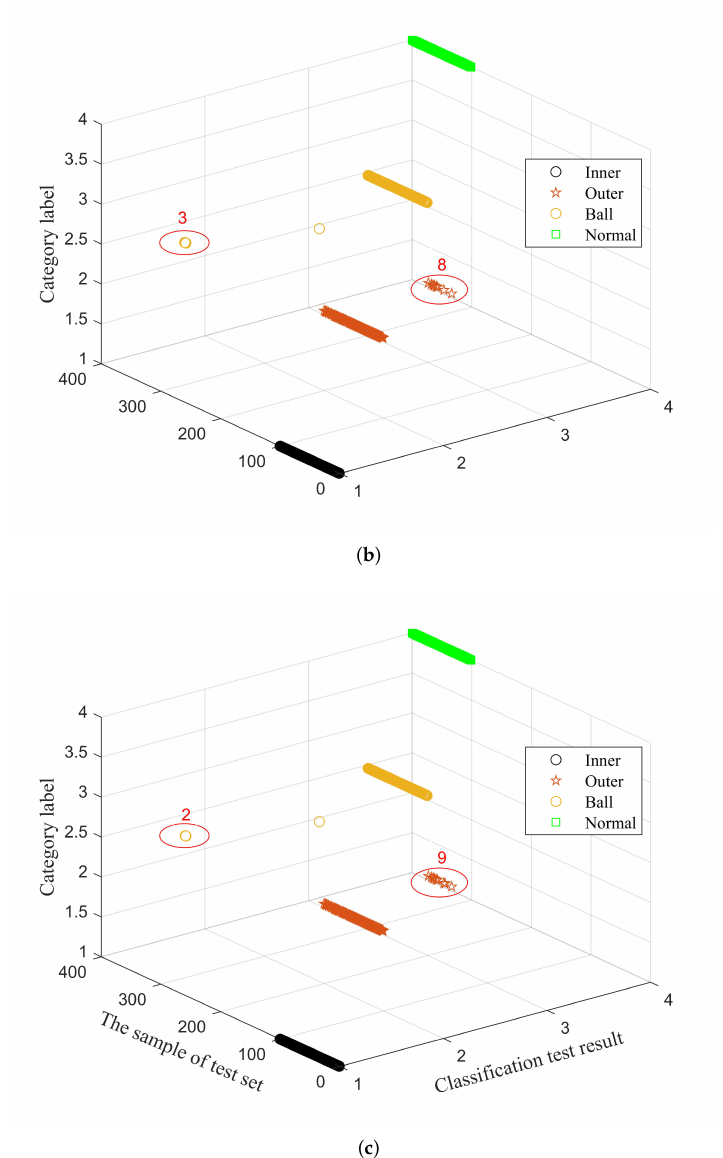
Figure 17. Accuracy of the DBN model after combining the different number of nodes in the hidden layers. ( a ) [100, 100], ( b ) [150, 150], ( c ) [250,